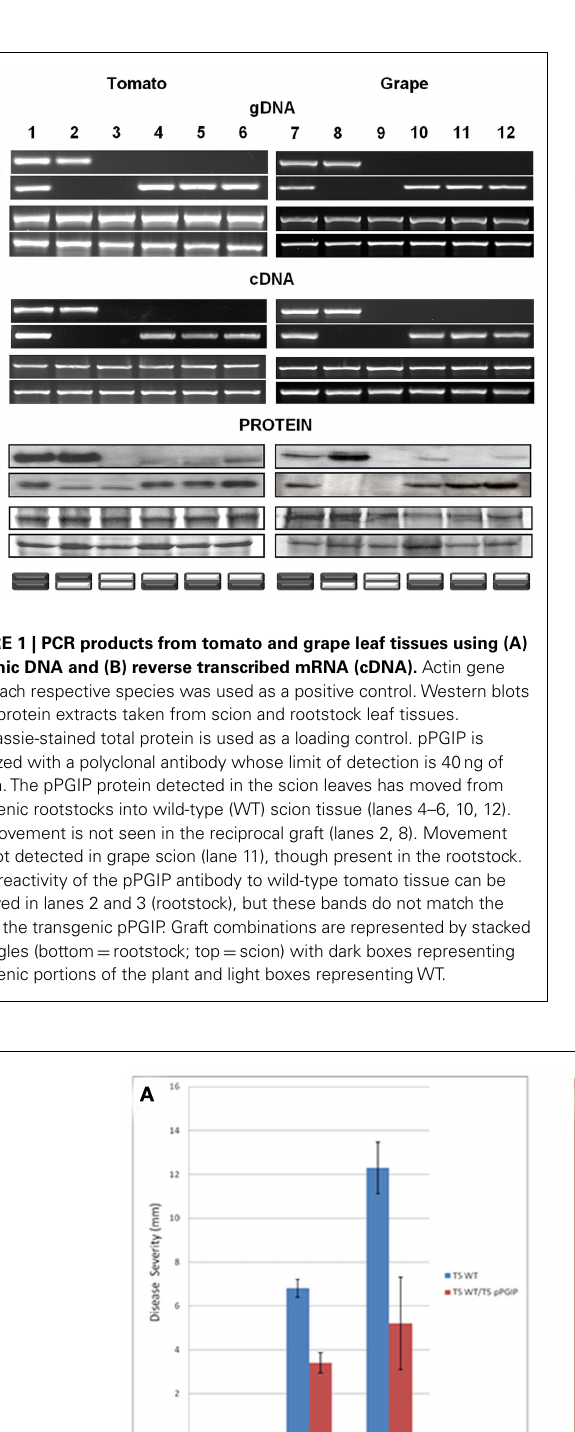
FIGURE 2 | Disease severity of B. cinerea infections ofT5 control (ungrafted) and transgrafted (T5:pPGIP rootstock withT5 scion) light red fruit. (A) Disease severity is measured as the diameter of the macerated tissue around the sites of inoculation. Each fruit was inoculated at five